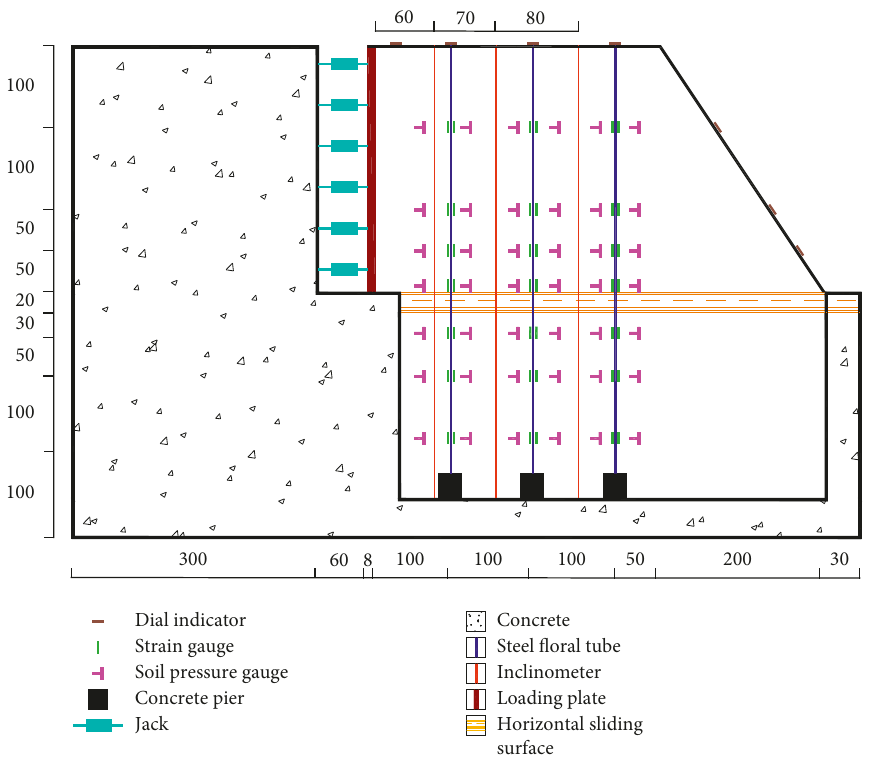
Figure 2: Schematic of the model tank (example arrangement diagram of Test D; all values in cm).